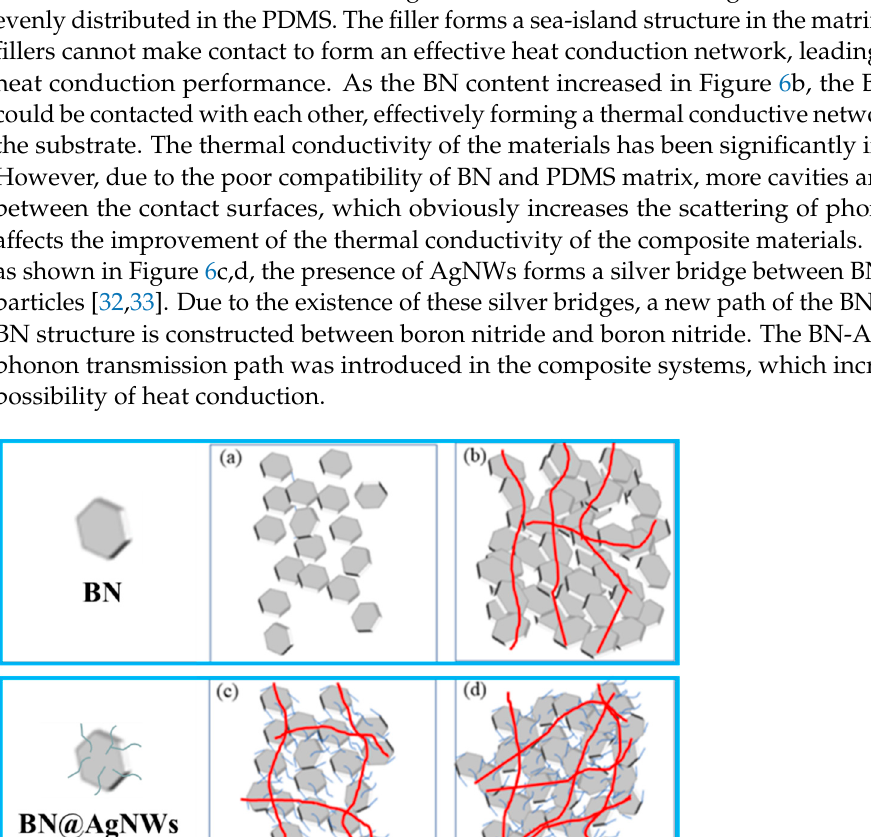
Figure 7. Tensile strengths ( a ) and elongation at break ( b ) of BN/PDMS and BN@15AgNWs/PDMS as a function of variant fillers contents.